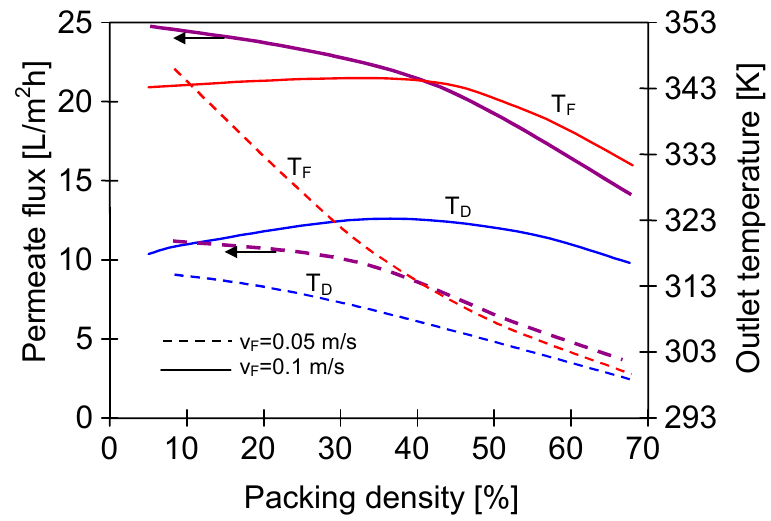
Figure 16. The influence of membrane packing density on the permeate flux and feed outlet temperature for various feed flow values. Mode 1. Distillate inlet temperature 293 K, feed temperature 353 K. v D = 0.4 m / s. Membrane Accurel PP S6 /